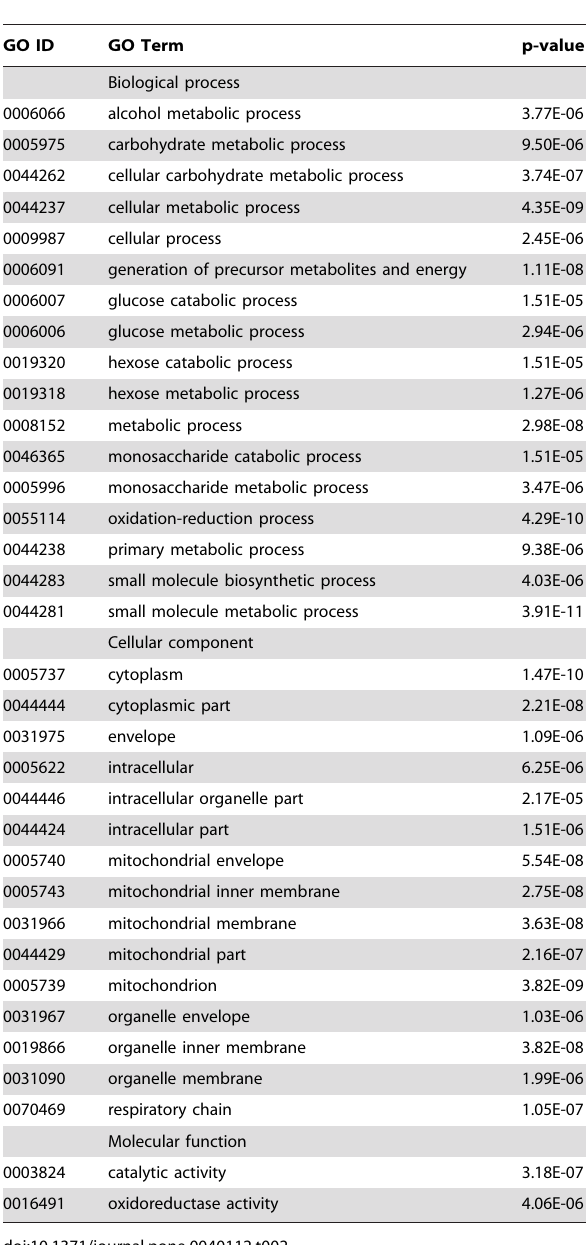
Table 2. Statistically significant GO terms derived from down- regulated genes (vs. ground